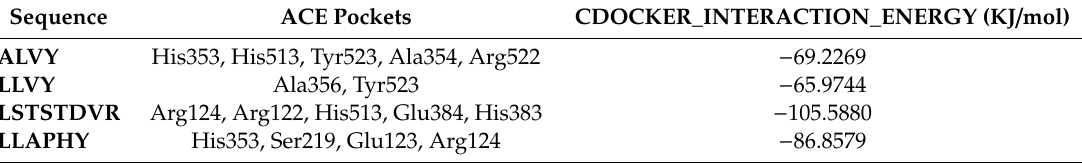
Figure 6. The molecular interactions of four peptides (identified from HILIC-FT / RP-F8 fraction) with ACE pockets: ( A ) ALVY, ( B ) LLVY, ( C ) LLAPHY, and ( D ) LSTSTDVR peptides. Table 2. Molecular docking of 4 peptides (identified from HILIC-FT / RP-F8 fraction) with ACE pockets.